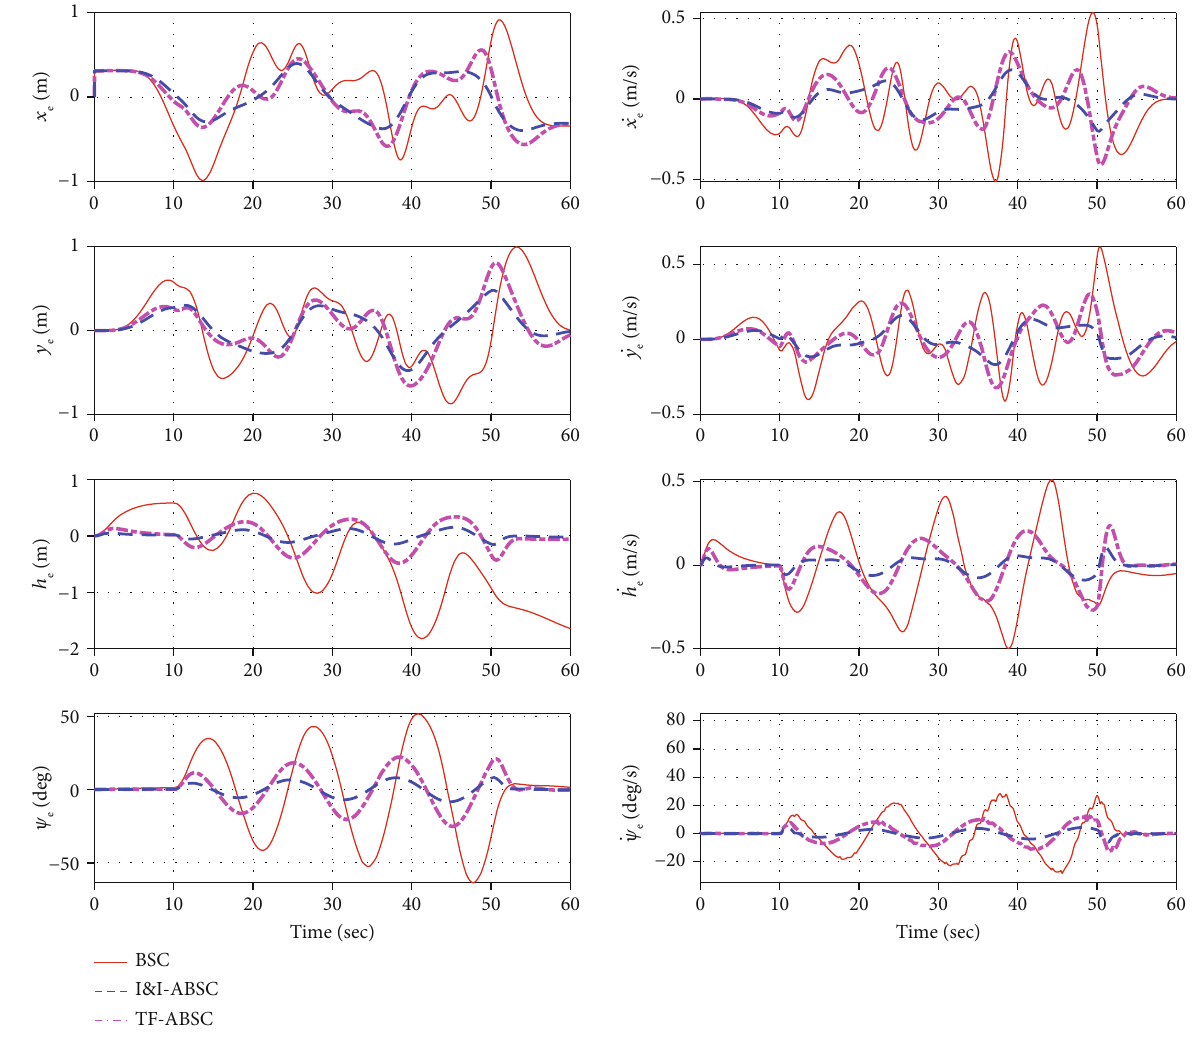
Figure 12: Case B: position and velocity tracking errors of BSC, TF-ABSC, and I&I-ABSC. Table 3: Case B: root-mean-squared tracking errors. Tracking